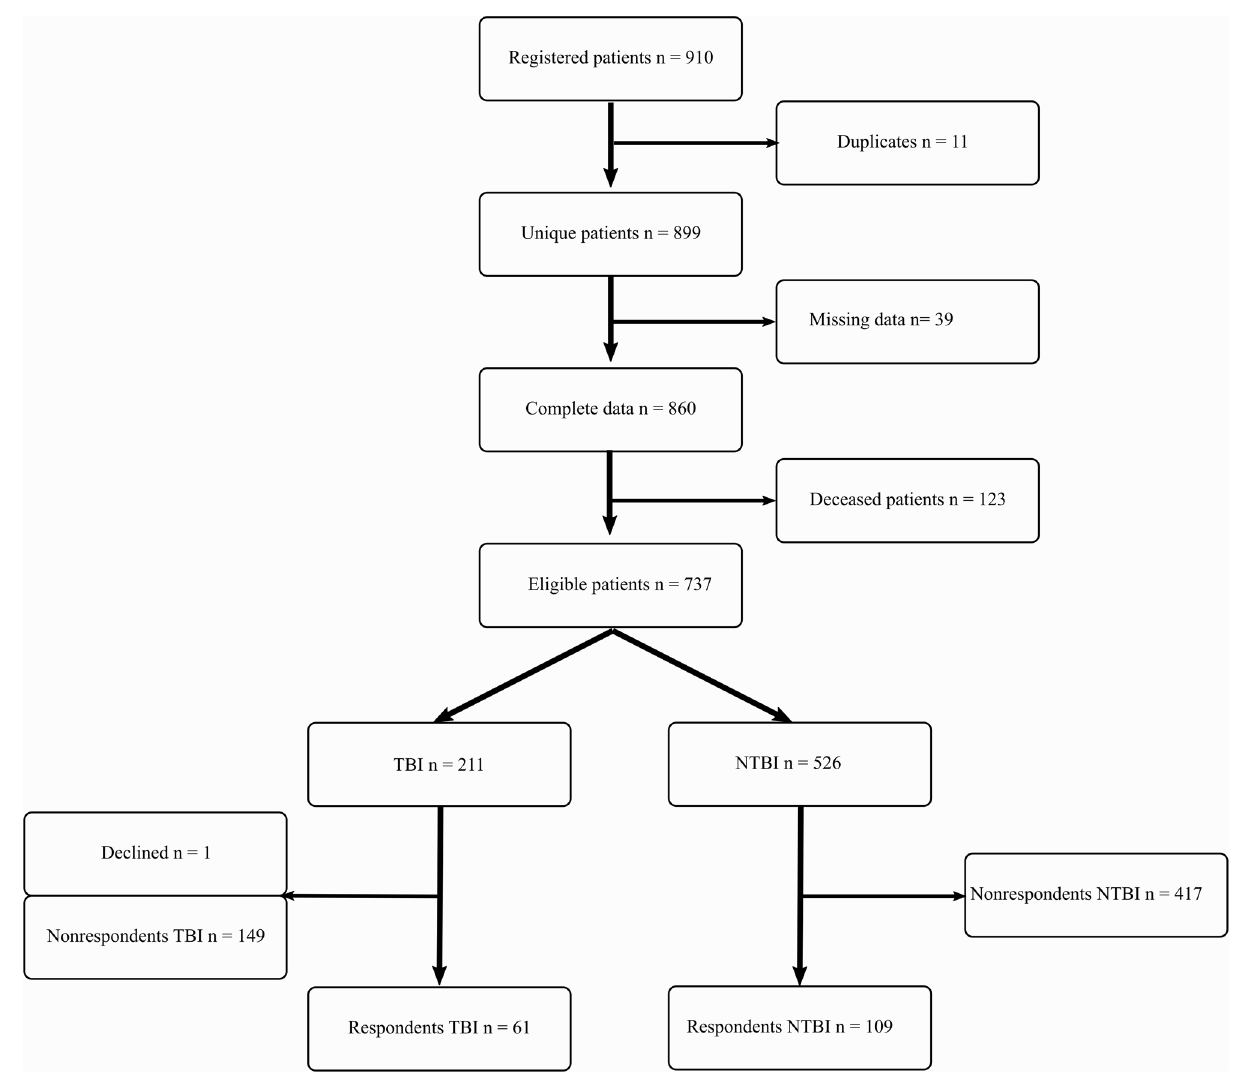
Figure 1. Enrolment in the study. A total of 11 patients were admitted more than once. Missing data includes foreign nationals not available for follow-up (n = 19) or missing contact details (n =